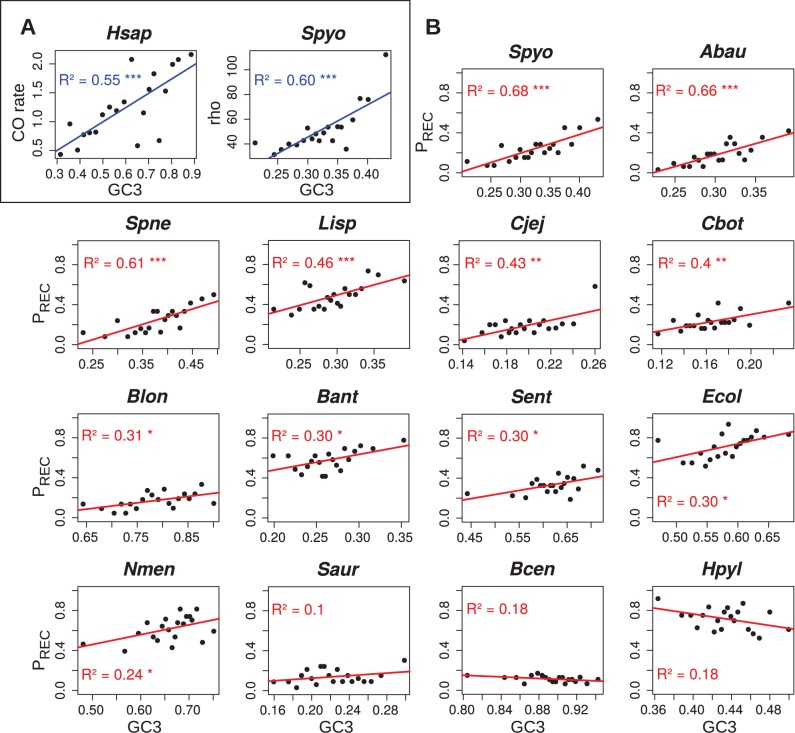
Correlations between GC3 and estimates of recombination rate.For each dataset, core genes are sorted by increasing GC3 and pooled into 20 classes of equal size. Correlations between the mean GC3 and mean recombination rate of each class are reported. (A) Correlation between GC3 and coalescent-based estimates of recombination rate for Homo sapiens (Hsap) and Stretococcus pyogenes (Spyo). For Hsap, recombination rate is expressed as cM∙Mb-1; a subset of 600 genes out of the 16,346 human genes is shown as a representative of 1,000 random samples (mean R2 is 55%, see Main Text). For Spyo, recombination rate is expressed as the value of rho parameter in ClonalOrigin [41] inferences, which is scaled by arbitrary coalescent time units; a subset of 437 genes out of 478 core genes was used, after removal of the 41 genes showing no convergence of the rho estimate (correlation on the full 478 core genes yields a R2 of 31%, see S1 Text). (B) Correlation between GC3 and PREC, the proportion of genes detected as recombinant by PHI test [28] in the class, for all 14 bacterial datasets showing sufficient evidence of recombination (Table 1).